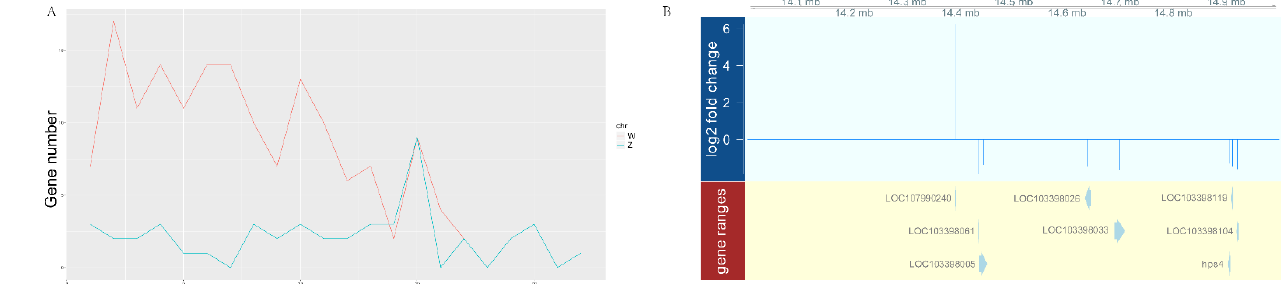
Figure 2. The chromosomal distribution of DEGs from sperm transcriptomes. ( A ) The circus plot of the genome features. From outer to inner: A distribution of downregulated genes; B, distribution of upregulated genes; C, distribution of DEGs; D, gene density; E, representing the 24 chromosomes. ( B ) The number of upregulated DEGs on each chromosome. ( C ) The number of downregulated DEGs on each chromosome.